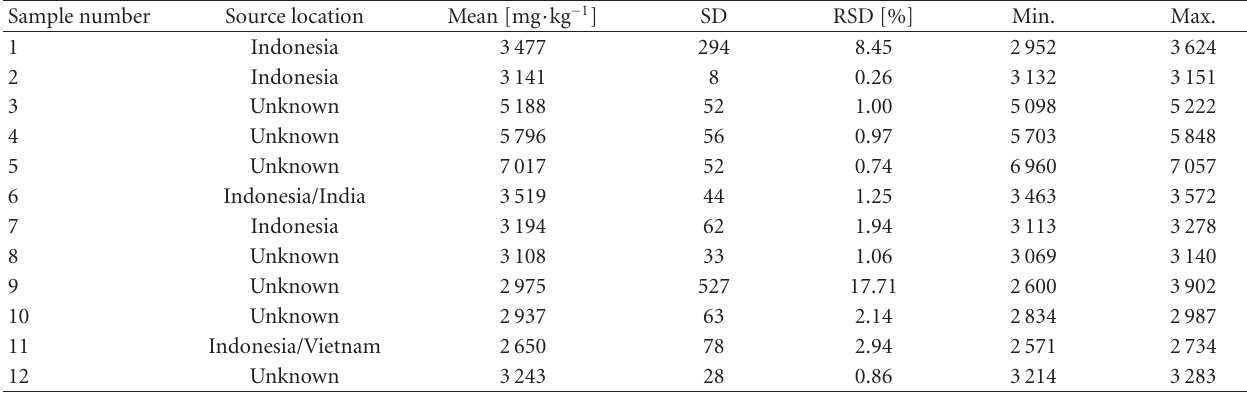
Table 1: Basic statistical parameters of coumarin content in samples of each ground cinnamon purchase from Czech retail markets (SD: standard deviation, RSD: relative standard